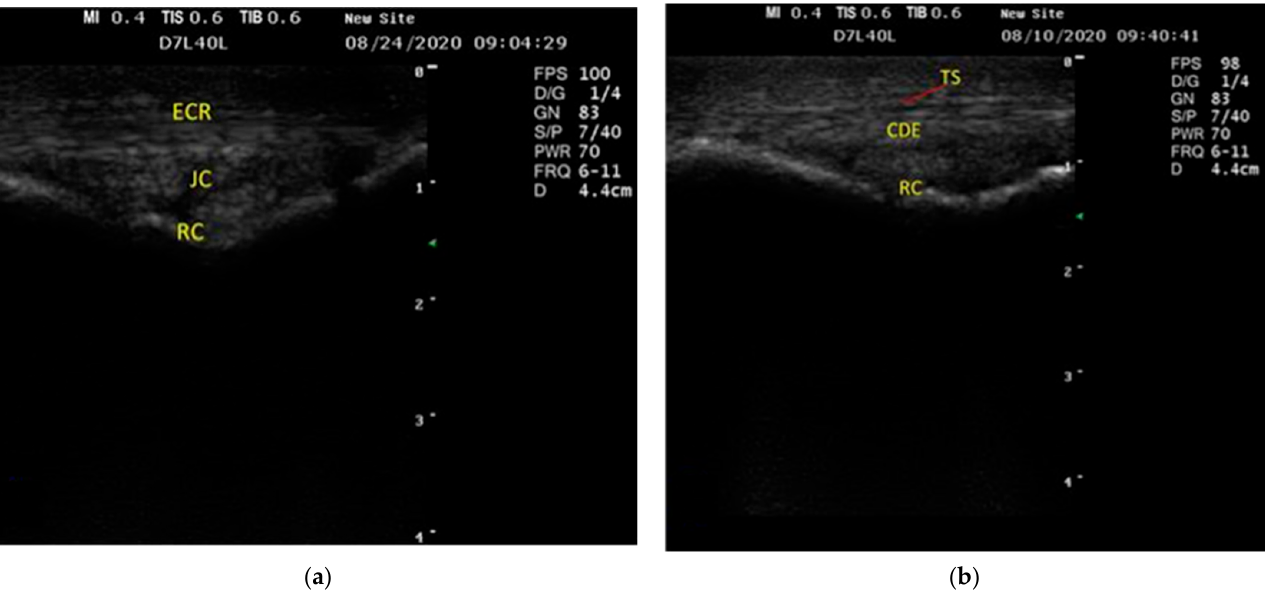
Figure 1. Longitudinal ultrasonographic scan of the dorsal ( a ) and dorsolateral features ( b ) of the carpal joint in donkeys showed that the extensor carpi radialis tendon (ECRT) appeared as a ho- mogenous echogenic structure characterized by a linear fiber outline. Behind the echogenic fibers of the ECRT, the joint capsule appeared as a hypoechoic structure with anechoic synovial fluid. The common digital extensor tendon appeared to be a homogenous echogenic structure with a thin anechoic sheath around the tendon. ECR, extensor carpi radialis tendon; CDET, communal digital extensor tendon; TS, tendon sheath; RC, radiocarpal joint; JC, joint capsule. The LCL appeared as a thin echogenic band that originated from the lateral styloid process of the ulna proximally and was introduced distally into the carpal bones (Figure 2a). The MCL appeared as a thick echogenic structure characterized by a linear fiber pattern at its proximal half and an irregular fiber pattern at the distal half (Figure 2b).